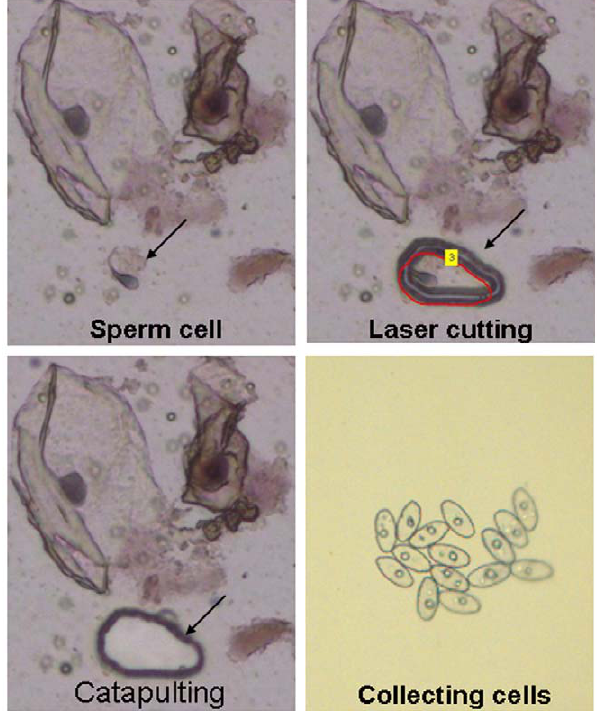
Figure 2. Sperm cell separation and collection by LCM. Samples were resuspended and placed on a PEN membrane slide. Sperm were identified by light microscopy (400 6 magnification), and removed by laser cutting. Finally, sperm cells were catapulted and collected onto a low-volume PCR slide.